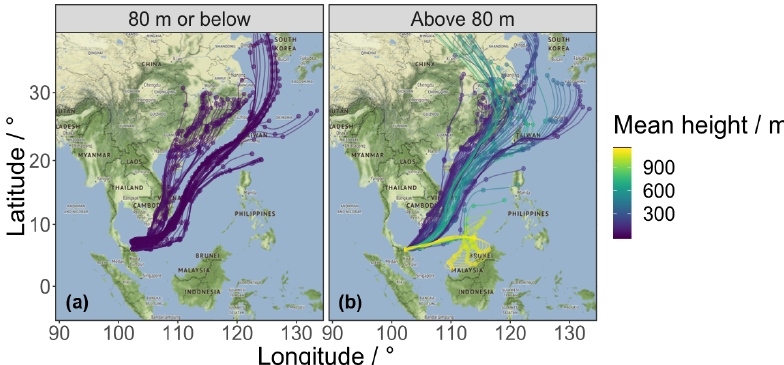
Figure 2. The 7-day HYSPLIT backward air mass trajectories centred on the Bachok Marine Research Station between 18 January and 7 February 2014. Each trajectory is coloured by the mean altitude (m). Trajectories with a mean height of 80m or below are shown in panel (a) and trajectories with a mean height greater than 80m are shown in panel (b) .